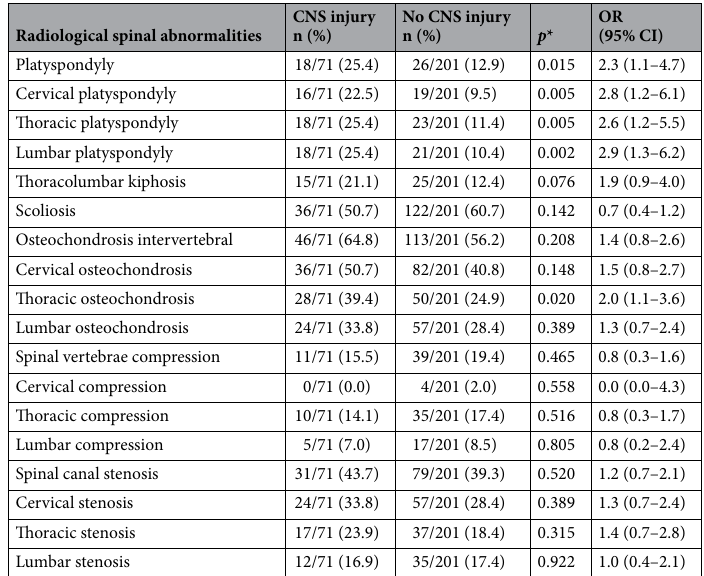
Table 7. Comparison of radiological spinal abnormalities between genetic skeletal disorder patients with and without CNS injury. CNS central nervous system, OR odds ratio, CI confidence interval. *X 2 test or Fisher’s exact test.